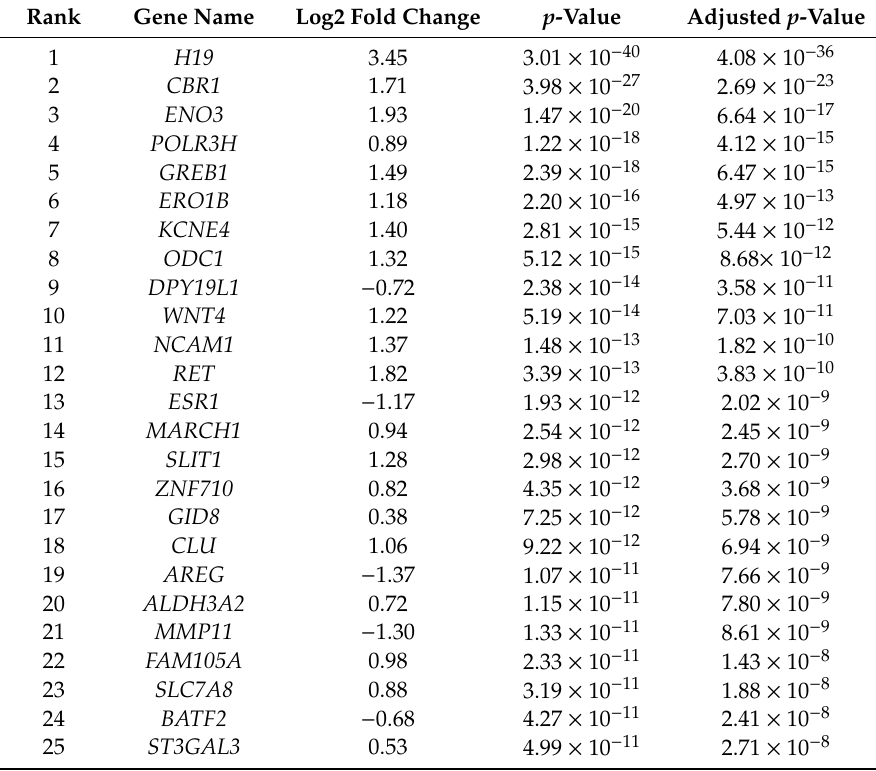
Table 7. Top 25 RNAs with statistical significance between the two